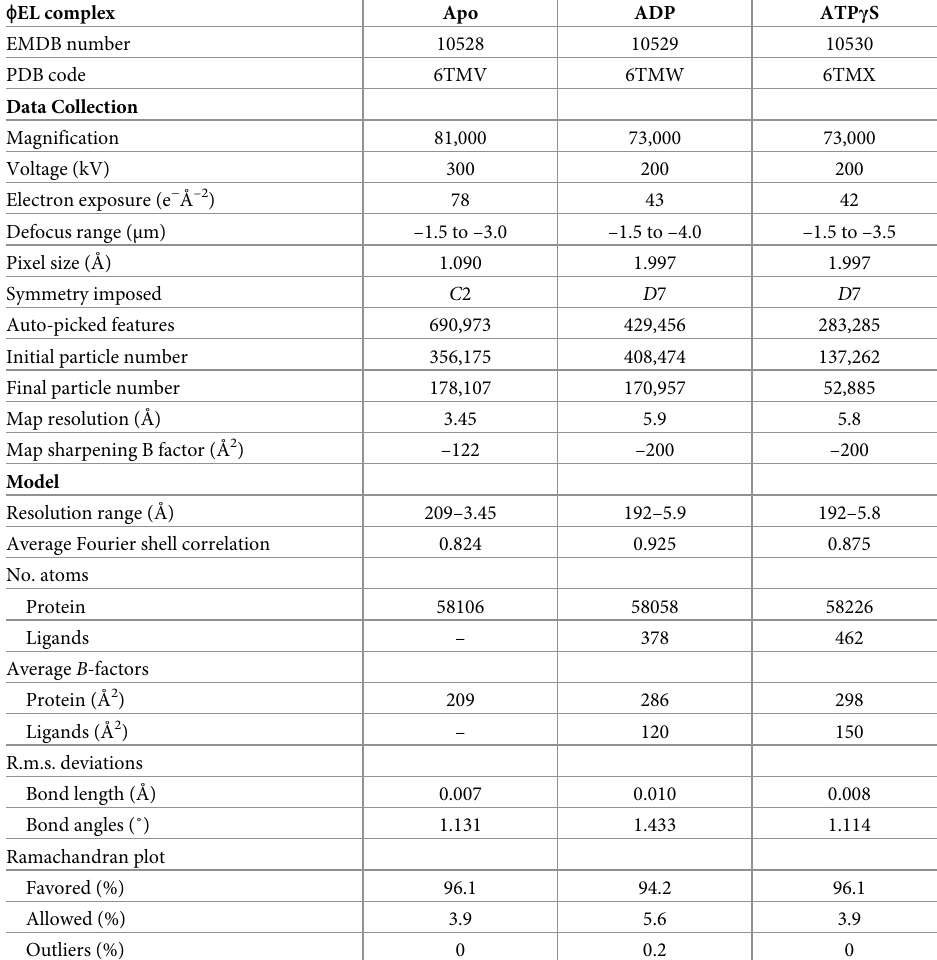
Table 2. Cryo-EM data collection and model